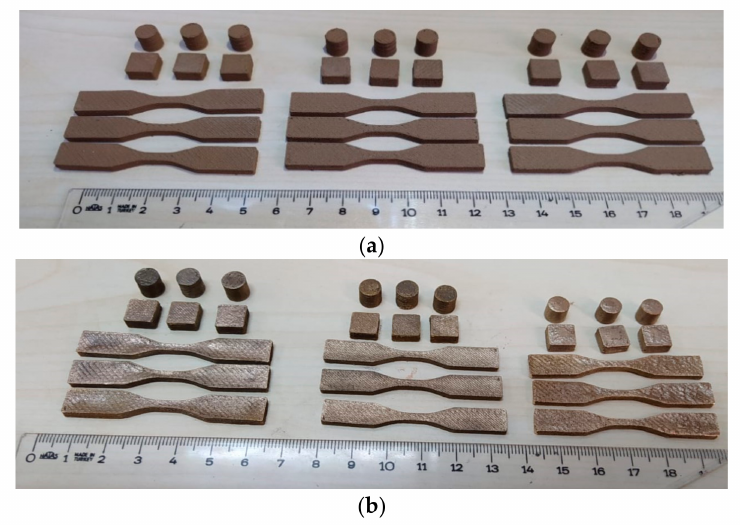
Figure 10. ( a ) Printed and ( b ) sintered test